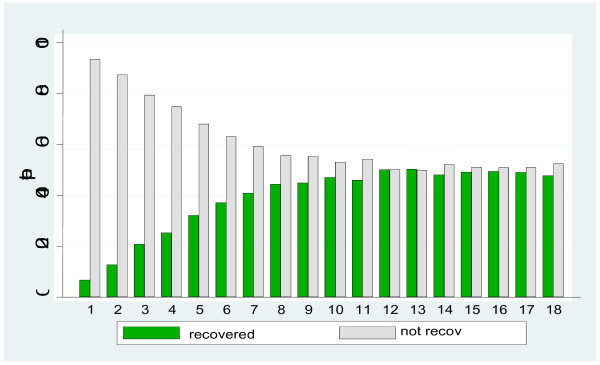
Percentage of patients recovered (LBP days = 0) and unrecovered in each of 18 weeks following a first visit to a chiropractor (n = 212 week one; n = 186 week 18).